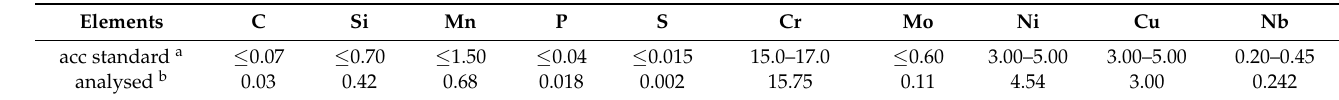
Table 2. 1.4542 (X5CrNiCuNb16-4, AISI 630), chemical composition in mass per cent.